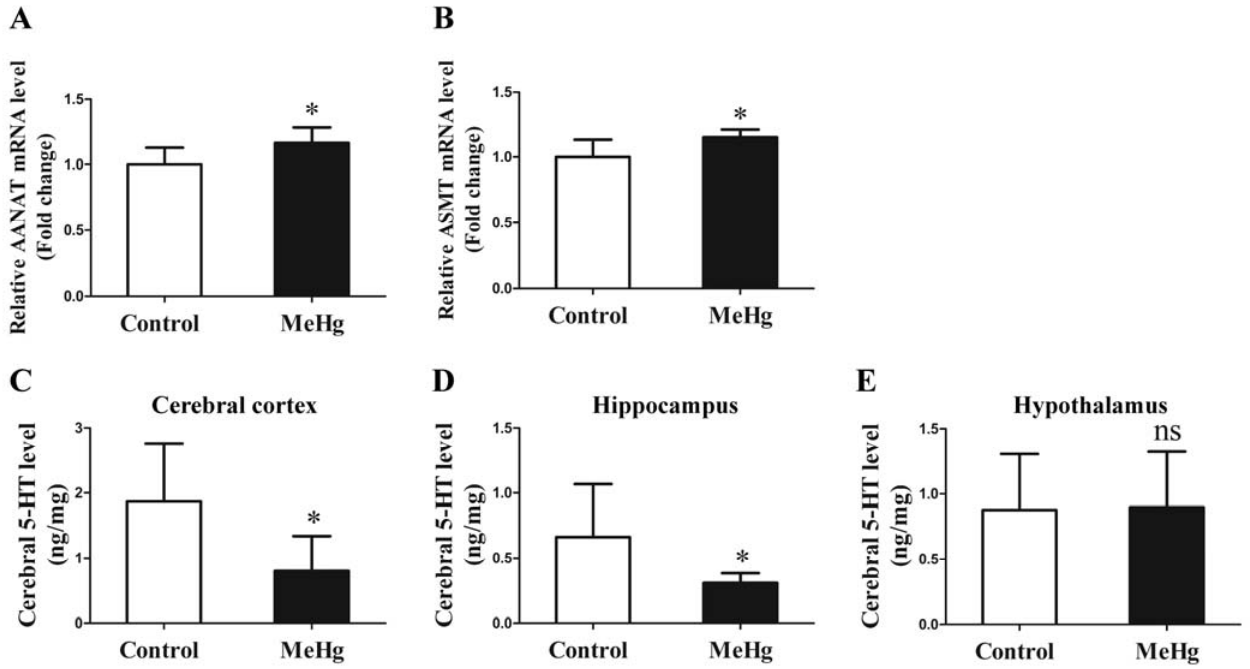
Figure 5. The influence of MeHg exposure on AANAT ( A ) and ASMT ( B ) mRNA expression level and in hippocampal tissue and 5-HT level in cerebral cortex ( C ), hippocampus ( D ) and hypothalamus ( E ). The data are expressed as mean ± SD for eight rats per group. ns, no significance compared to the control group, p > 0.05. * p < 0.05, significant difference compared to the control group.